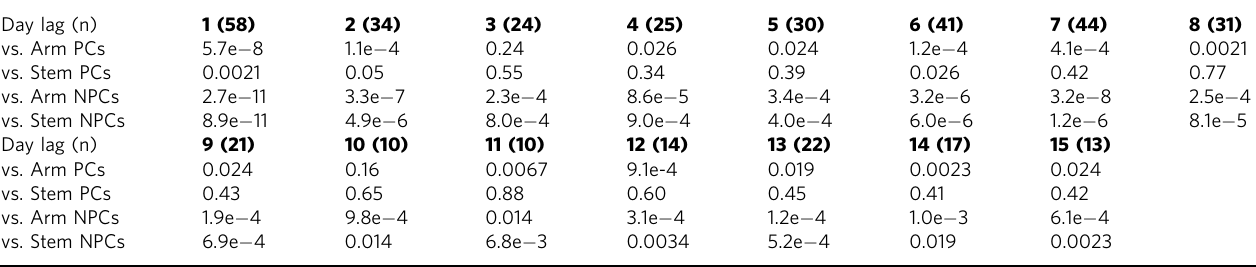
Table 2 One-sided signed-rank signi fi cance values for the probability stem pcs with high vs. low trajectory reliability stay active between sessions ( n = session pairs).